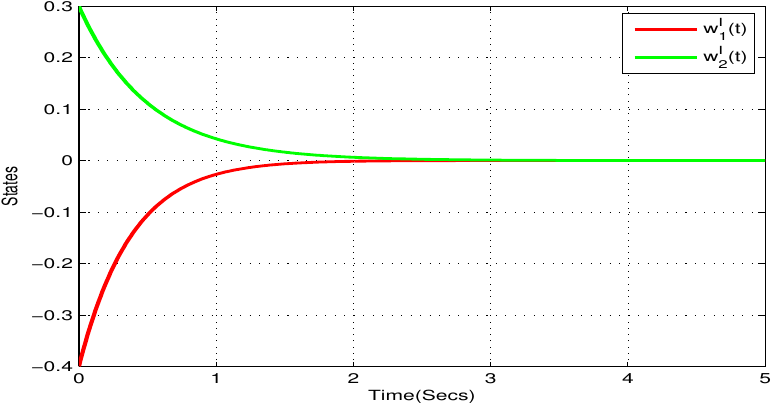
( t ) , w I ( t ) of systems (22) in Example 1. 2 1